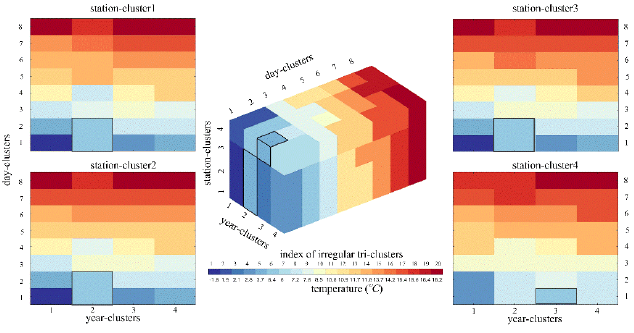
Fiugre 4. 3D heatmap (center) and 2D heatmaps (side subplots)